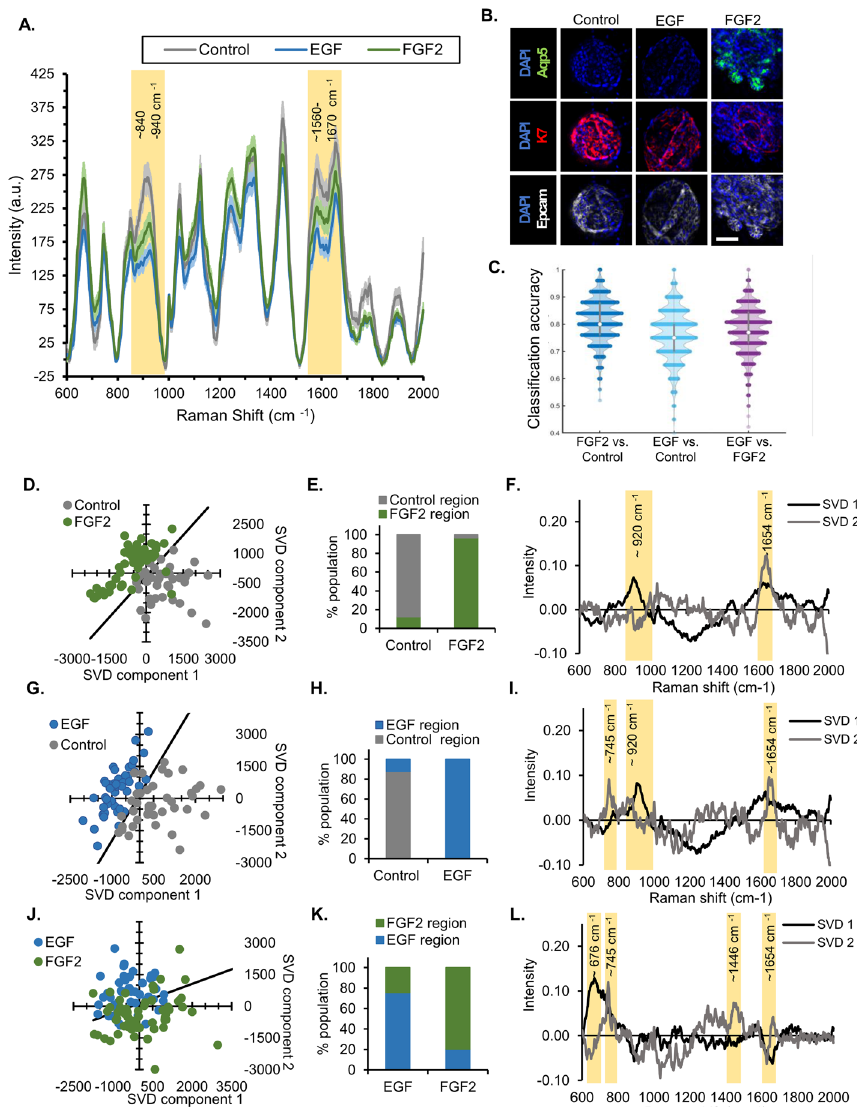
Fig. 7 FGF2-differentiated live organoids with distinct Raman signature. A Average Raman spectra for cell dense regions of control, EGF-treated, and FGF2-treated organoids, with error bars representing the 95% confidence interval. B Representative images of salivary gland organoids that were first subjected to live Raman imaging prior to fixation and immunostaining to confirm the proacinar (AQP5) cells in FGF2-treated organoids, additional stains for epithelial cells (EpCAM), ductal cells (K7), and nuclei (DAPI). Scale bar, 100 µm. Larger images and quantification shown in Additional file 1: Fig. S5. C Classification accuracy of machine learning (RSVM) on live Raman organoid dataset (228–267 spectra per comparison, Standard deviation less than 0.10 for all comparisons). D – L Multivariate SVD analysis of representative experiment with control versus FGF2 ( D – F ), control versus EGF ( G – I ), and EGF versus FGF2 ( J – L ). For each comparison, there is an SVD plot where each dot represents a single spectrum, with clustering of similar spectra ( D , G , J ). The distribution of the spectra in each region is plotted in E , H , and K , while the SVD components producing the distribution are plotted in F , I , and L . Select regions of interest within the component graphs are highlighted in yellow ( n 40 separate spectra collected from a minimum of three independent organoids per condition, = + representative experiment shown of three replicate